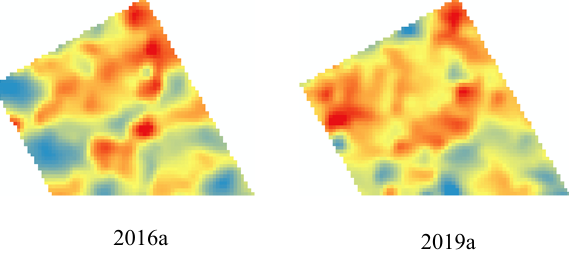
Figure 3. Inversion Results of Area 1 Surface Temperature